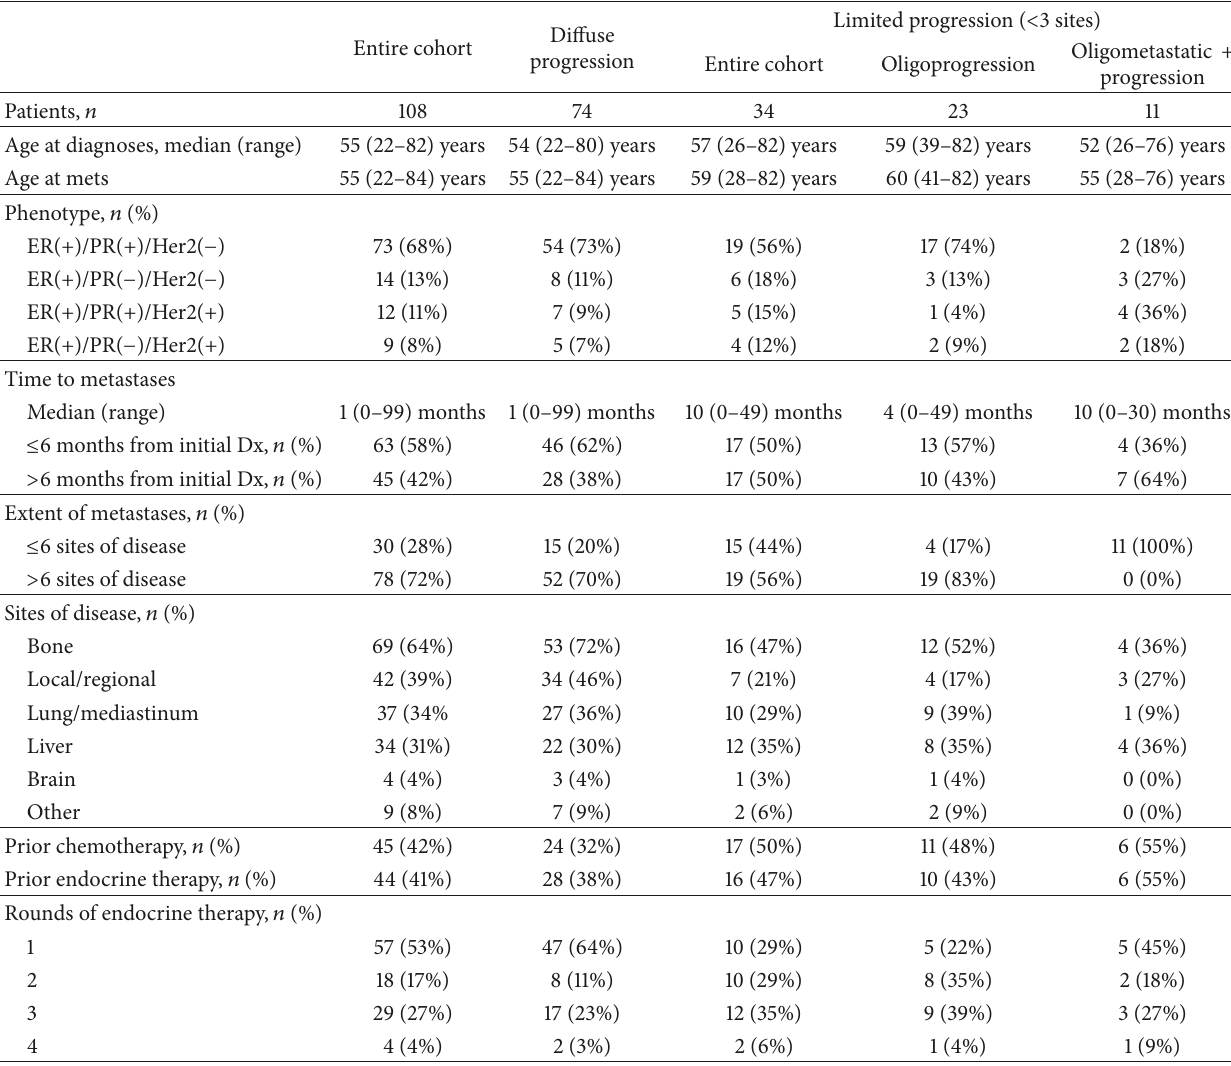
Table 2: Patient, tumor, and treatment